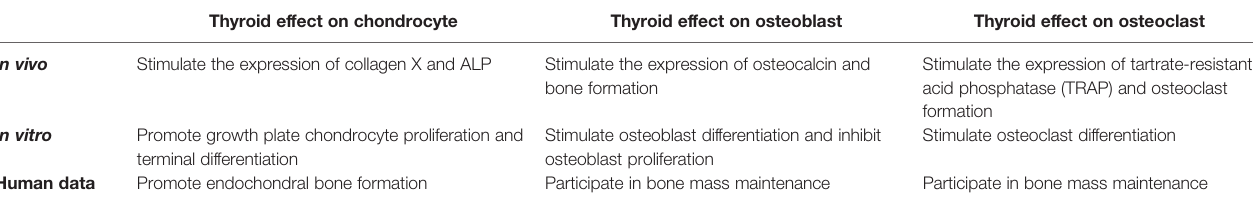
TABLE 1 | Thyroid effect on the components of the bone tissue.